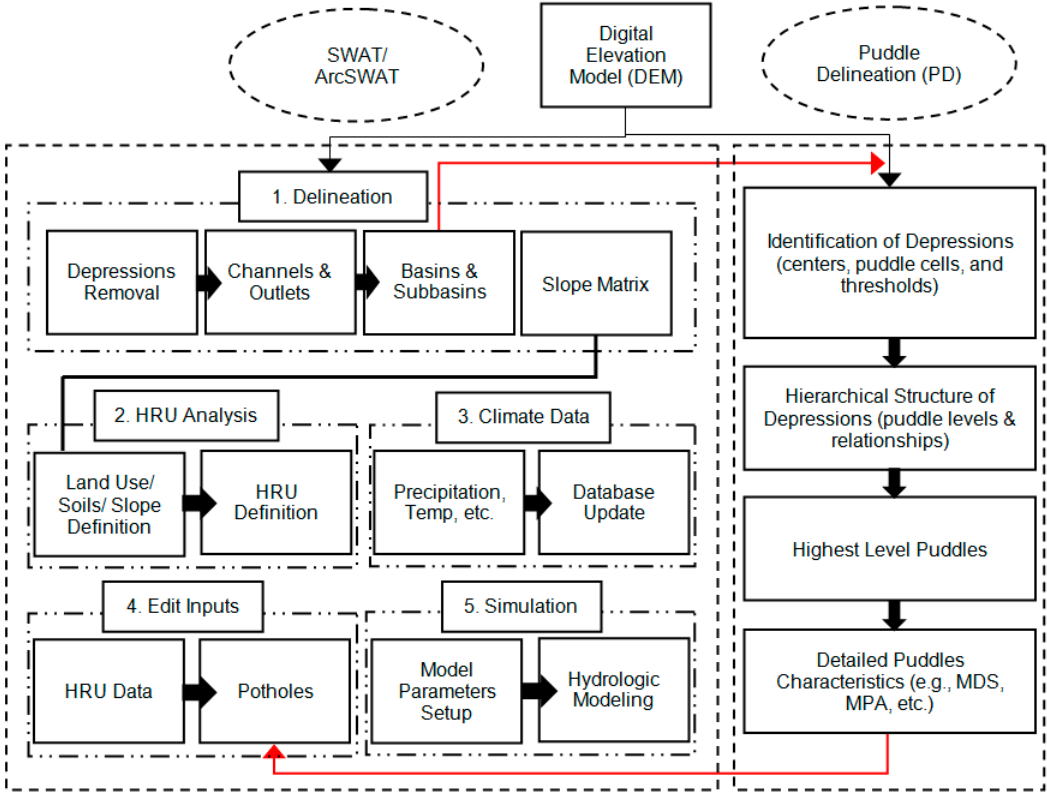
Figure 1. Fundamental steps of the coupled SWAT and Puddle Delineation (PD) modeling system (MDS: maximum depression storage, MPA: maximum ponding area, and HRU: Hydrologic Response Unit).